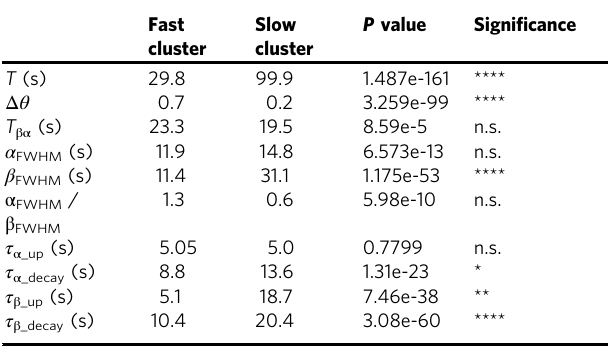
Table 1 The mean value of the features in the fast and slow